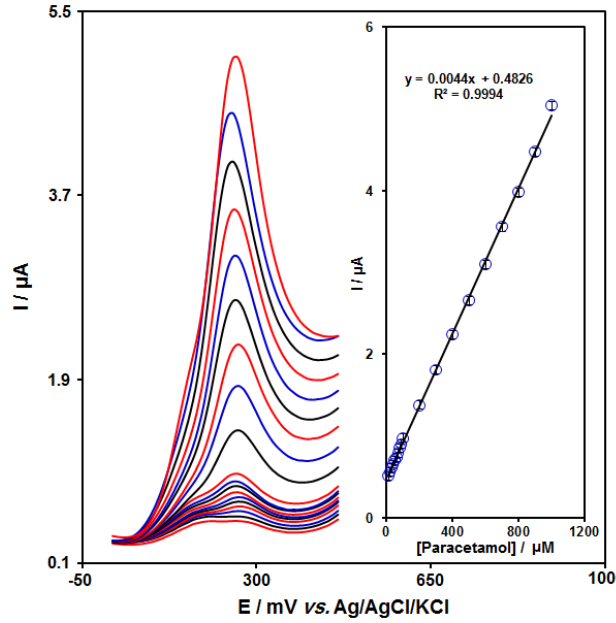
Fig. 8 Fig. 8. DPVs of Cu/SPE in 0.1 M (pH 7.0) containing different concentrations of paracetamol. From inner to outer correspond to 10.0. 20.0, 30.0, 40.0, 50.0, 60.0, 70.0, 80.0, 90.0, 100.0, 200.0, 300.0, 400.0, 500.0, 600.0, 700.0, 800.0, 900.0 and 1000.0 µM of